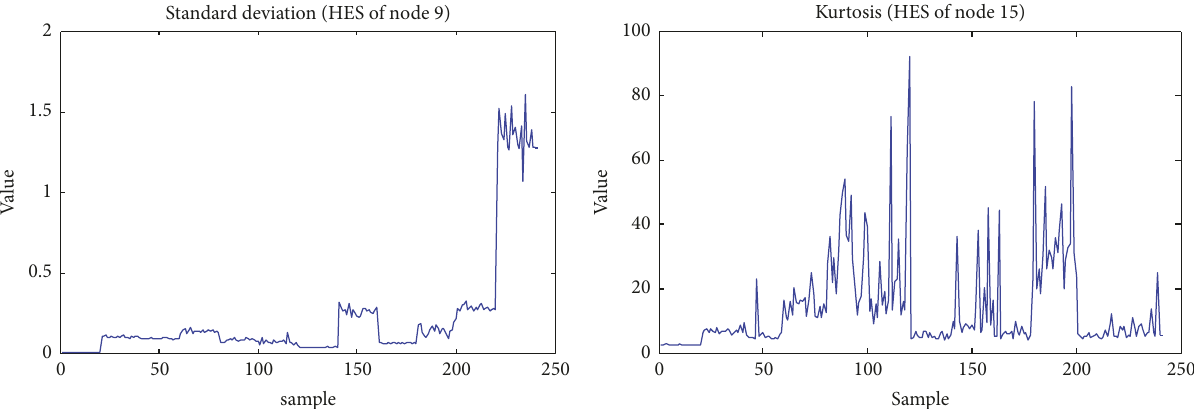
Figure 6: Two HES statistical characteristics of the training